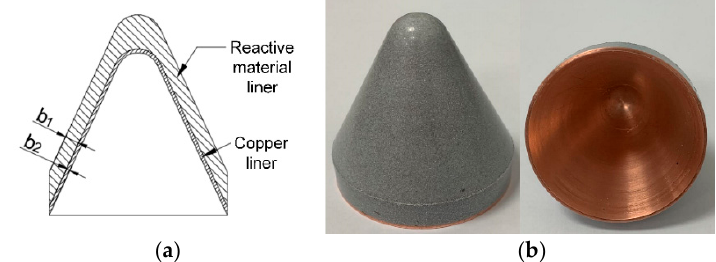
Figure 3. Structure and photograph of the RM-CL specimen. ( a ) Structure of liner; ( b ) Liner specimen.